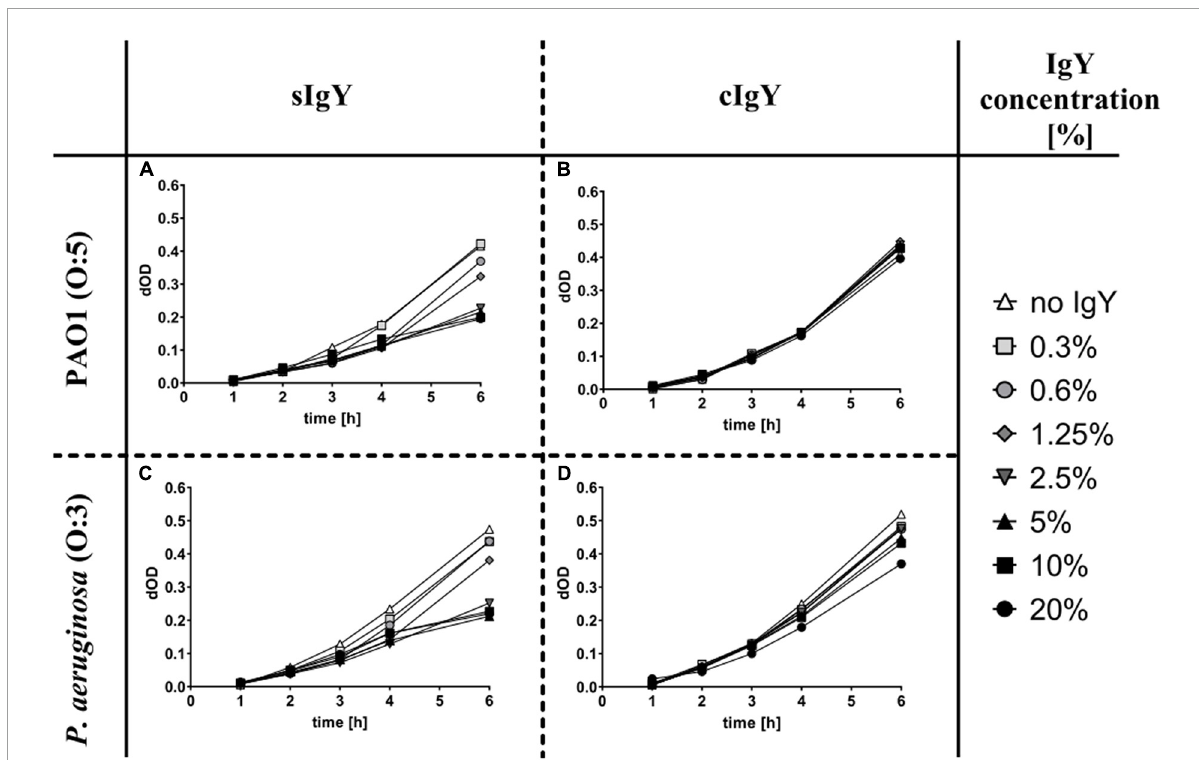
FIGURE1 Growth retarding effect of specific anti- Pseudomonas IgY in vitro . Pseudomonas aeruginosa PAO1 (A,B) and PAO3 (C,D) were grown in lysogeny broth (LB) overnight, centrifuged, resuspended in Krebs-Ringer buffer (KRb), opsonized with human AB + serum and then diluted 60 times in LB to reach a final well concentration of approx. 5 × 10 6 CFU/mL. Specific (A,C) and non-specific (B,D) IgY were diluted to the desired concentrations (final well concentrations between 20 and 0.3%). Human PMNs were isolated from healthy volunteers and cell counts were adjusted to reach final well concentrations of 1.75 × 10 6 cells/mL. The 96-well plates were read hourly in a multiplate reader at 600 nm for up to 6 h. The start reading was subtracted from the following readings as the background. Displayed are the changes in OD (dOD), corresponding to the bacterial growth over time.